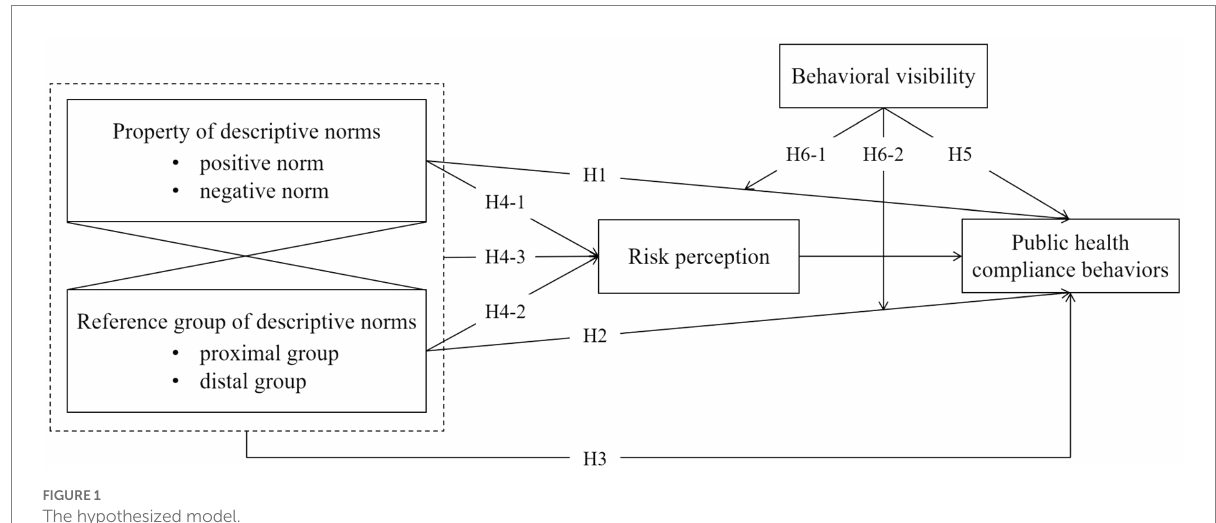
FIGURE 1 The hypothesized model. Note. The dotted box represents the interaction between the property and the reference group of descriptive